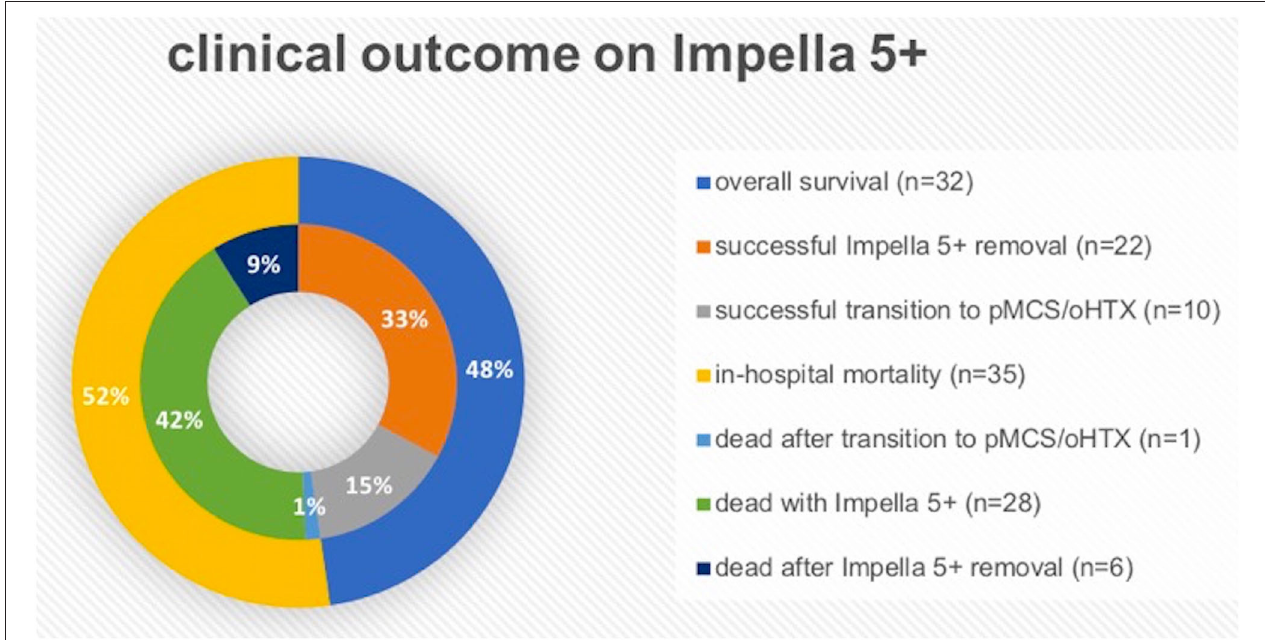
FIGURE 2 | The graphic explanation of clinical outcome on Impella 5 + (5.0 or 5.5). oHTX, orthotopic heart transplantation; pMCS, permanent mechanical circulatory support.